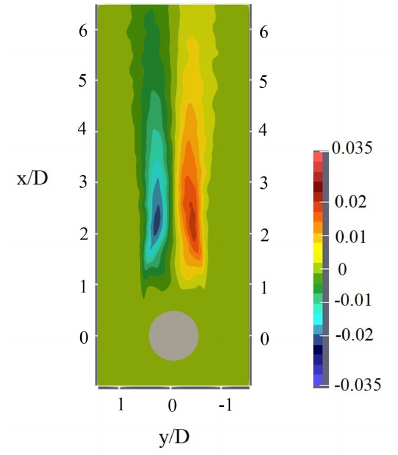
Figure 17. Reynolds stress component u (cid:48) v (cid:48) / u 2 ∞ for flow past the simulated sphere at Re =